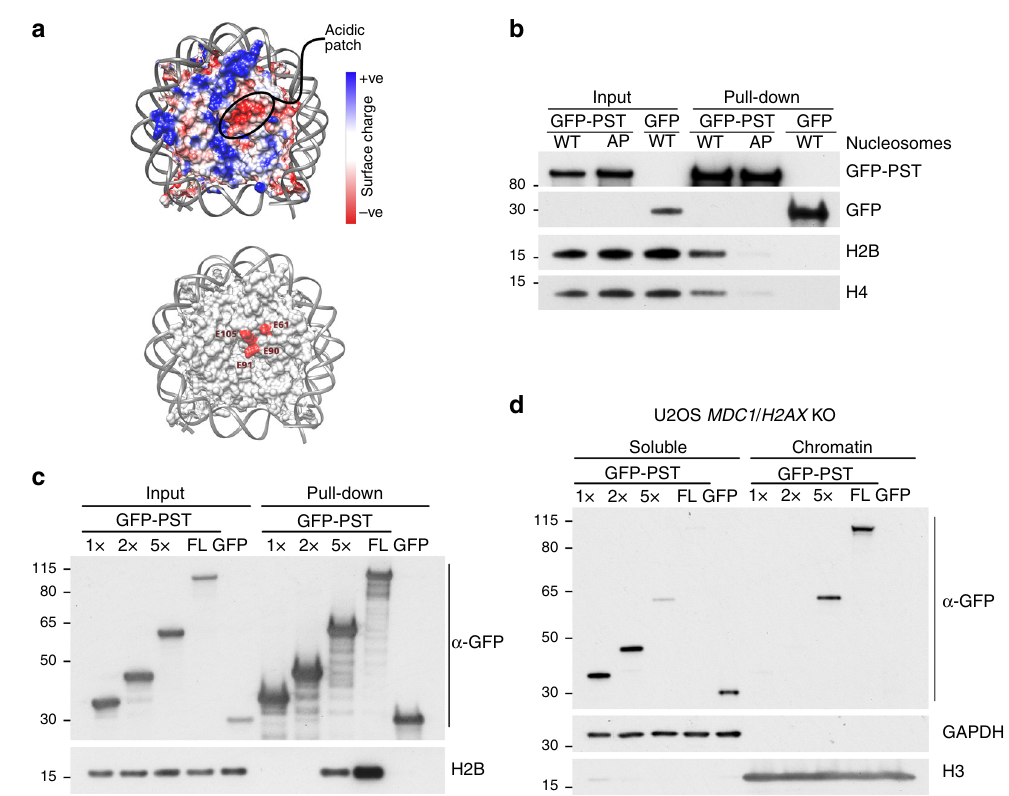
Fig. 5 Binding of MDC1 PST region to chromatin is mediated by the nucleosome acidic patch and requires several PST repeats. a Depiction of the nucleosome and its acidic patch. Top: electrostatic potential view of the nucleosome surface, coloured according to coulombic surface charge. Bottom: view of the nucleosome surface and localisation of the mutated acidic patch residues. b Biochemical binding assay between GFP-PST or GFP-only and mono- nucleosomes reconstituted using recombinant histones. WT, all core histones are wild-type; AP, acidic patch mutant with the H2A E61/91/92 A and H2B E105A point mutations. c Biochemical binding assay between different GFP constructs, containing 0, 1, 2 or 5 repeats or the full-length (FL) PST fragment, and native mono-nucleosomes puri fi ed from HeLa cells. d Chromatin fractionation of U2OS MDC1 − / − H2AX − / − cells transfected with plasmids expressing the indicated GFP-PST constructs or